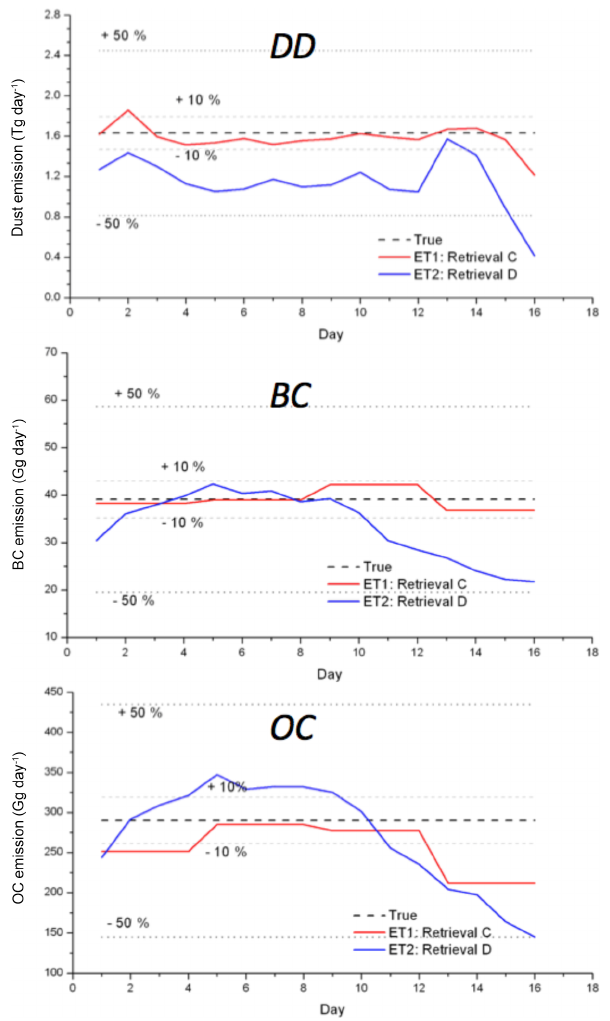
Figure 9. Sensitivity test for retrieving DD, BC and OC emissions over 16 days with two scenarios of assumption of emission correc- tion time resolution.